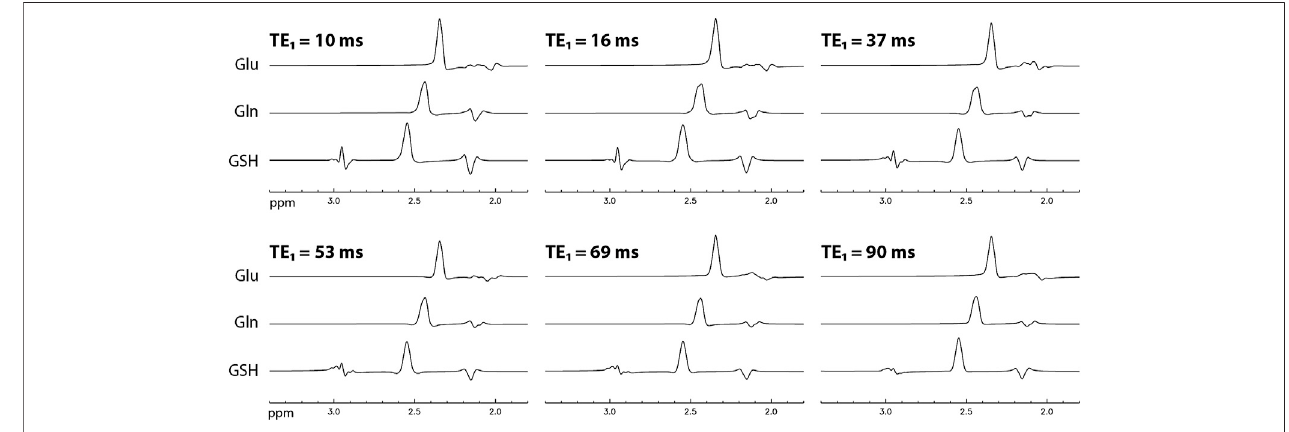
FIGURE2| NumericallycomputedspectraofGlu,Gln,andGSHwithequalconcentrationatTE=106 msandsixselectedTE 1 values.Allspectrawerebroadened to a Lorentzian linewidth of 9 Hz.